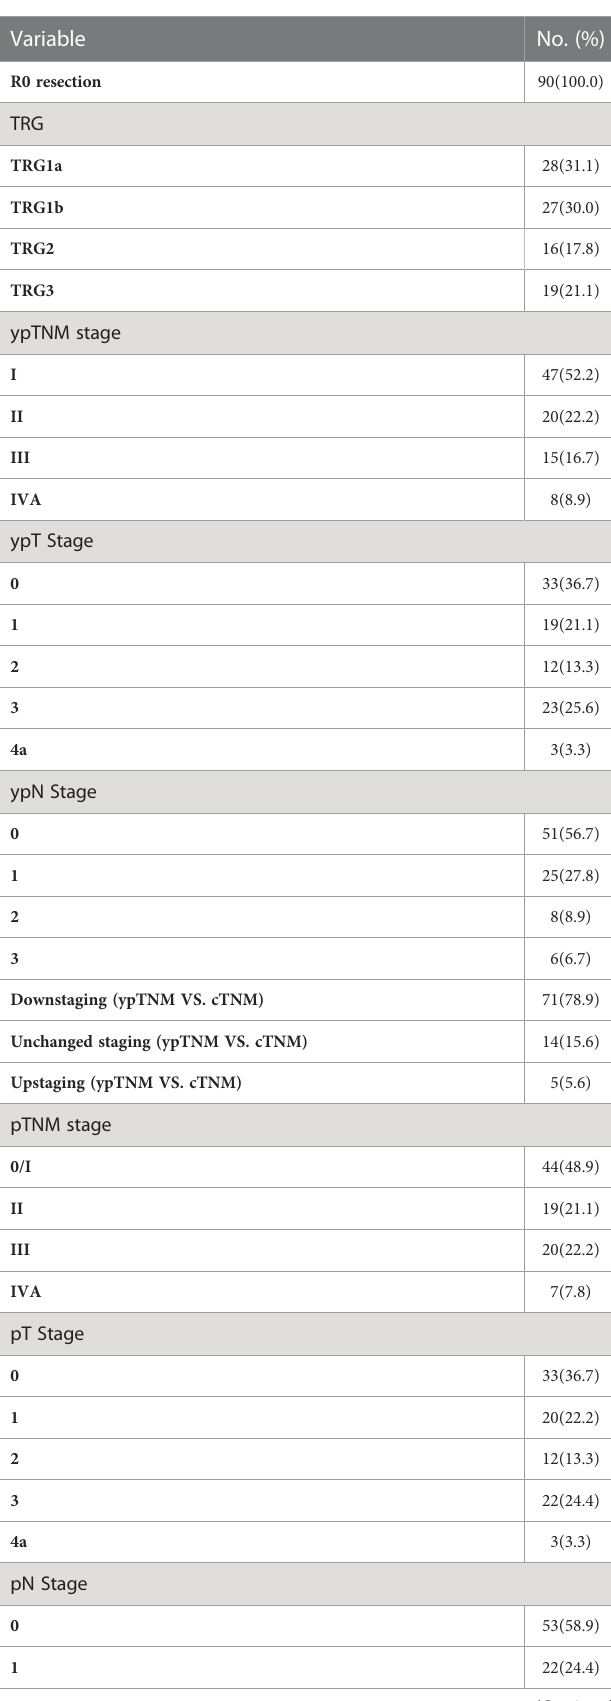
TABLE 2 Radiologic and pathologic